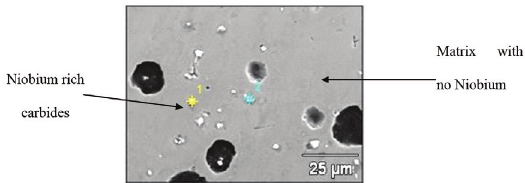
Figure 3. Typical microstructure of a NCI with Niobium (SEM; EDS analysis at points 1 and 2).